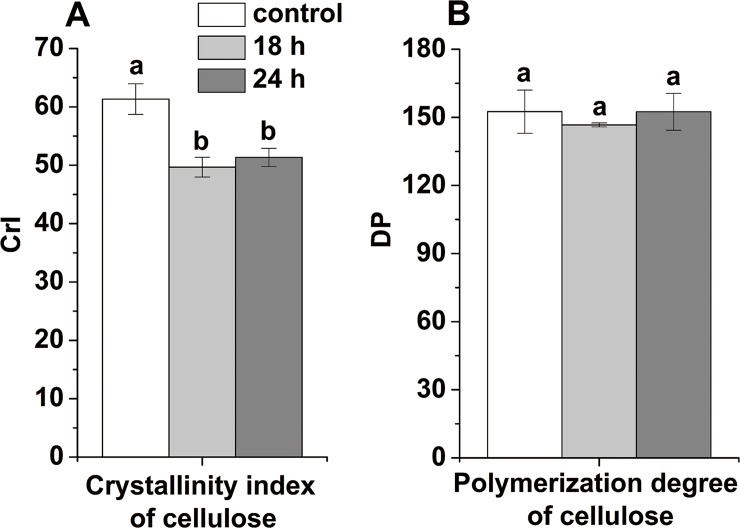
Cellulose characteristics in the switchgrass stem.(a) Cellulose crystallinity indexes, and (b) depolymerization degree of cellulose in the switchgrass stem. The different small letters in each group of columns indicate the significant difference at level of P < 0.05 or 0.01, respectively. The bar indicates SE (n = 5).